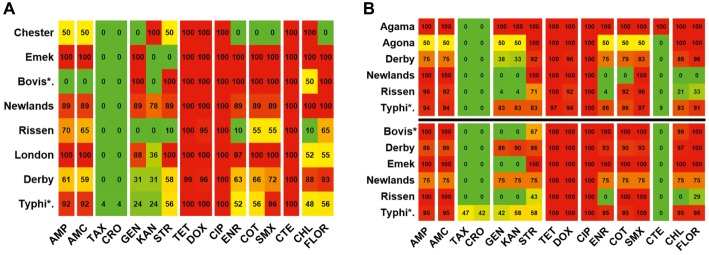
Antibiogram of the slaughterhouse and farms isolates. (A) Resistance distribution in the slaughterhouse serovars. The difference in the resistance of serovars is statistically significant (p = 0.0010), while the difference among the individual antibiotics is highly significant (p < 0.0001). (B) Resistance distribution in the farm serovars. The upper half (above the black horizontal line) is the distribution in the large-scale farms while the lower half (below the black horizontal line) is the distribution in small- and medium-scale farms. The variation of the resistance among the serovars was statistically non-significant (p = 0.2984) in either type of the farms, whereas the variation between the individual antibiotics was statistically significant (p < 0.0001). The color scale of the individual cells is quantified by the numerical value given within the cells. Abbreviated names of the serovars are Bovis*: Bovismorbificans and Typhi*: Typhimurium.